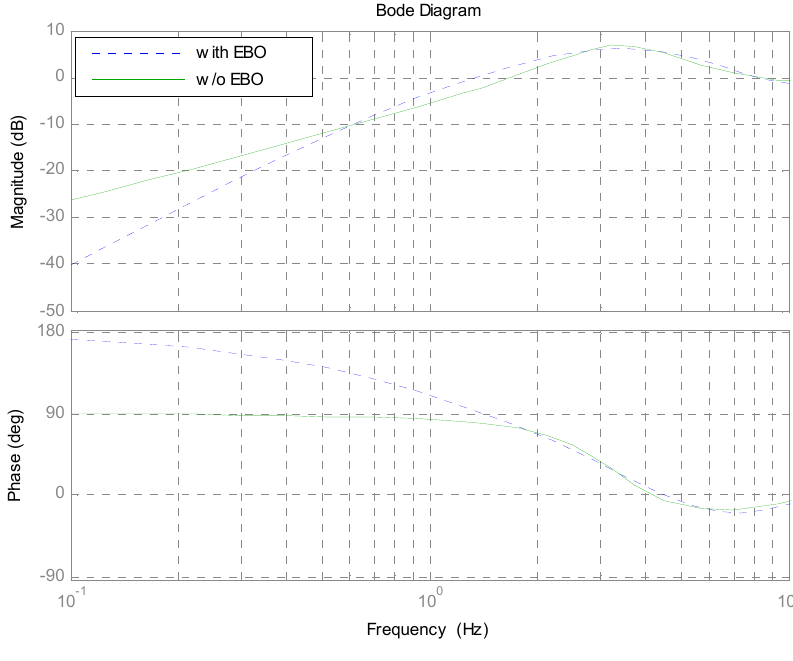
Figure 4. Bode response of error attenuation.